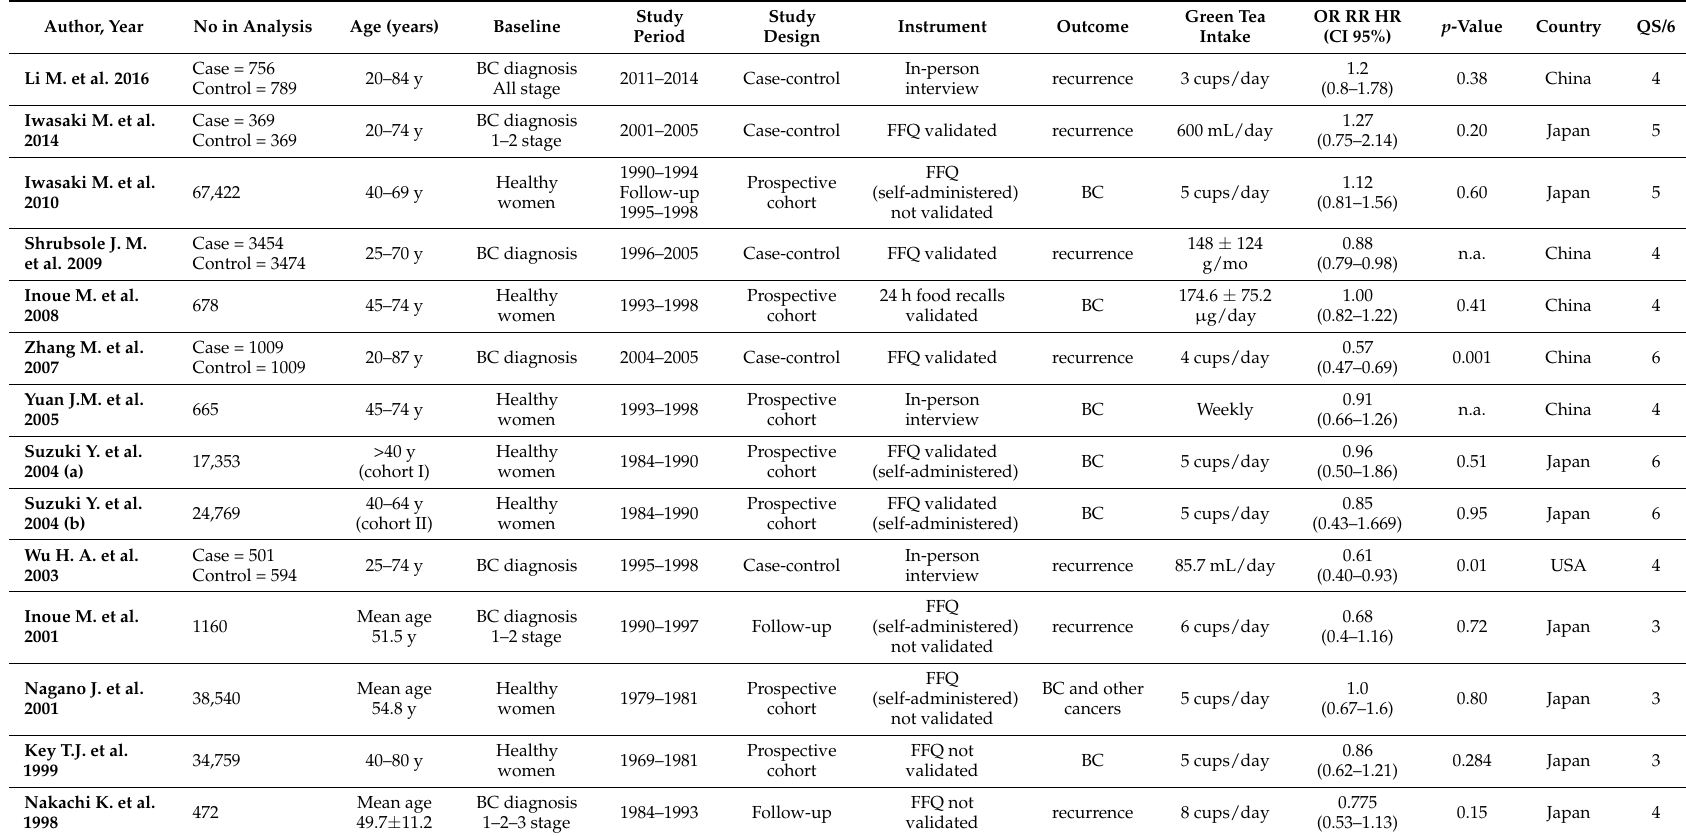
Table 2. Characteristics extracted from the included studies and quality